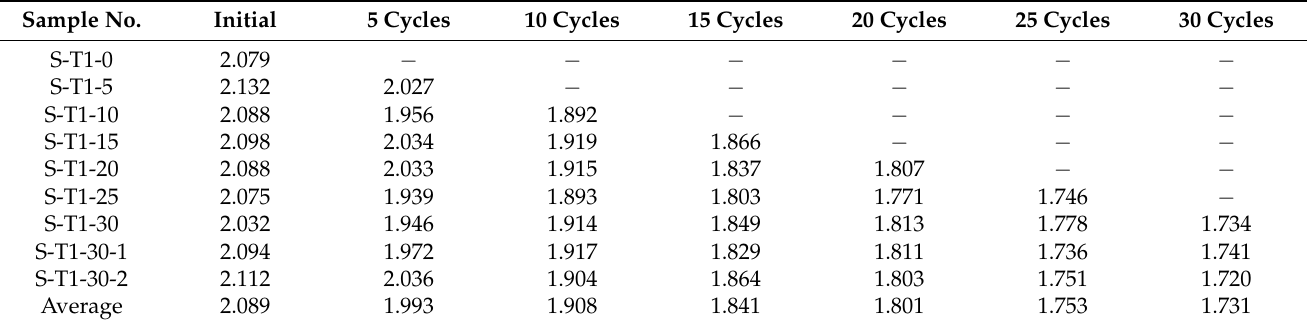
Table 2. P -wave velocity after different numbers of freeze–thaw cycles with a freeze–thaw temperature of − 20 ◦ C. Sample No.